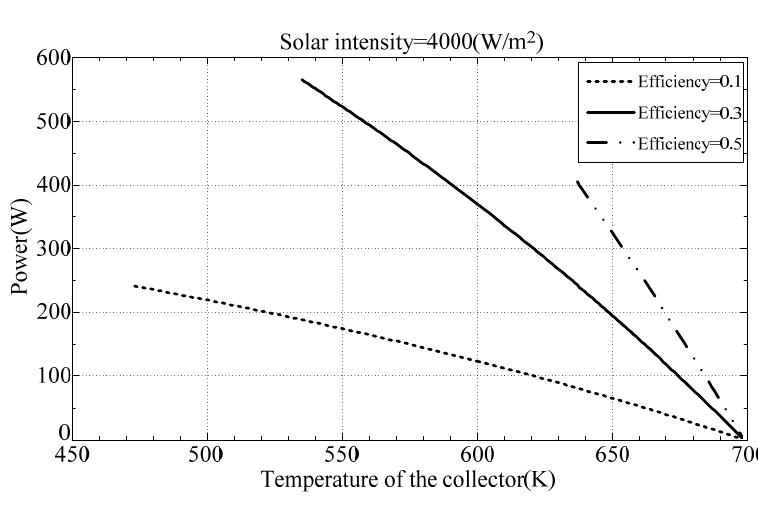
Figure 3. Engine output power.